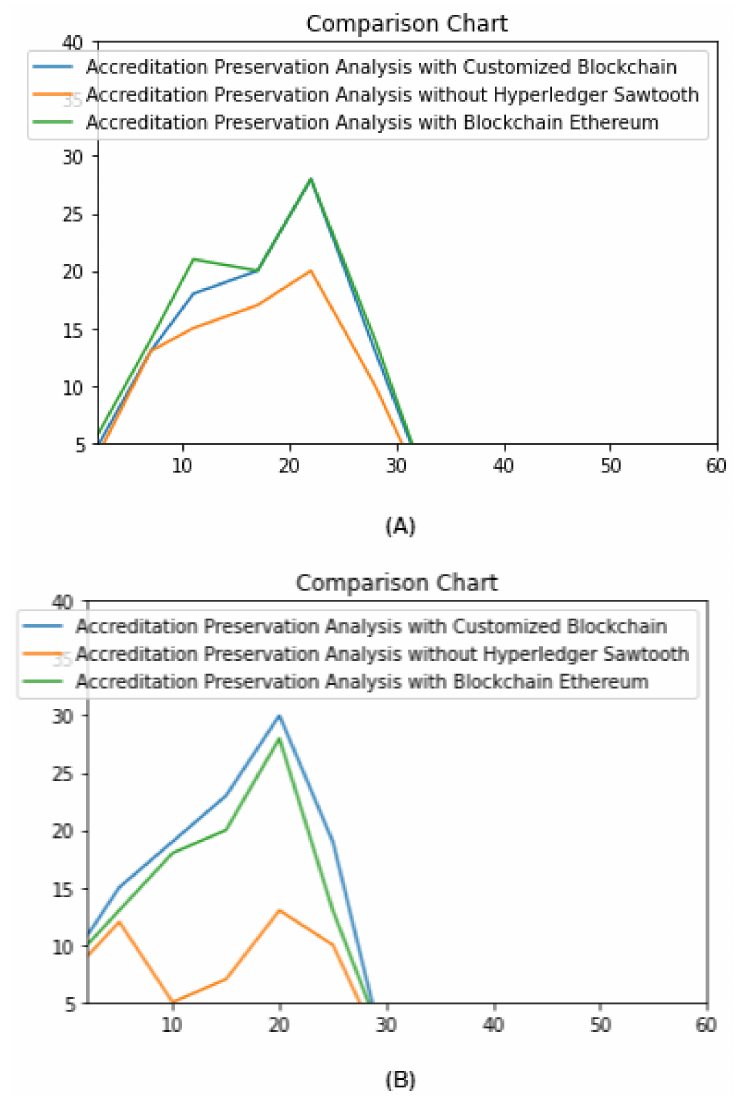
Figure 9. Blockchain comparison chart (A) Comparison Between Blockchain Permissioned Architec- ture with Public Permissionless Structure, (B) Analytical